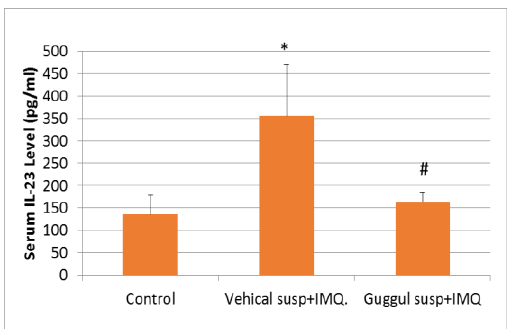
Figure 4. Effect of oral administration of guggulsterone on serum IL-23 level in imiquimod-induced psoriasis in mice.